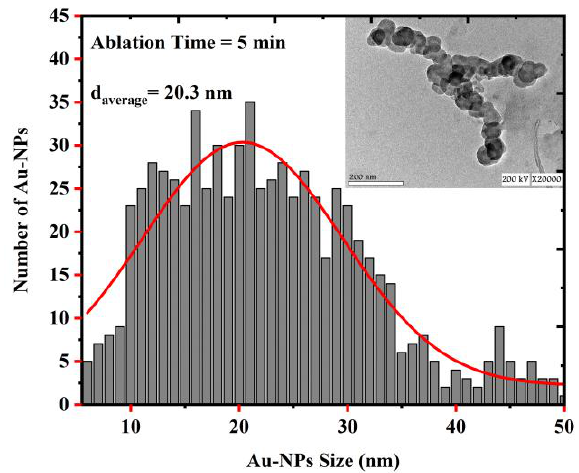
Figure 3. The size distribution of Au NPs that were prepared using a 5 min laser ablation time.